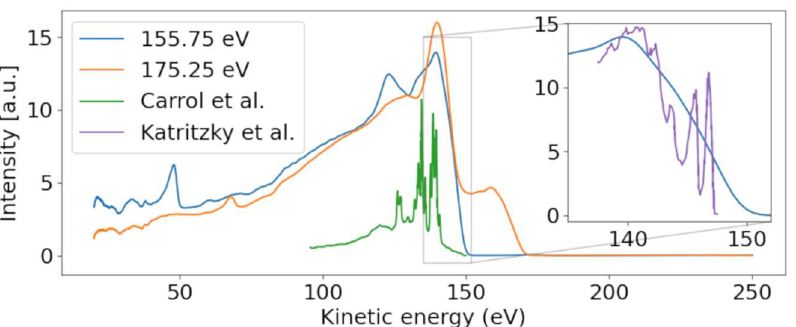
Figure 3. Photoelectron spectra for photon energies above (175.25 eV) and below (157.25 eV) the sulfur 2p binding energy. A dispersive behavior of the valence band is visible, moving from ~140 to ~160 eV with increasing photon energy. Our valence spectrum at hυ = 155.75 eV is compared with a He-lamp-induced valence photoelectron spectrum (purple) from Ref. [24] in the inset, which is scaled in kinetic energy according to the difference of photon energies used in the experiments. Conversely, the Auger–Meitner feature is only present for the higher photon energy. The Auger–Meitner data are compared with the sulfur Auger–Meitner spectrum of OCS (green) from Ref. [26].